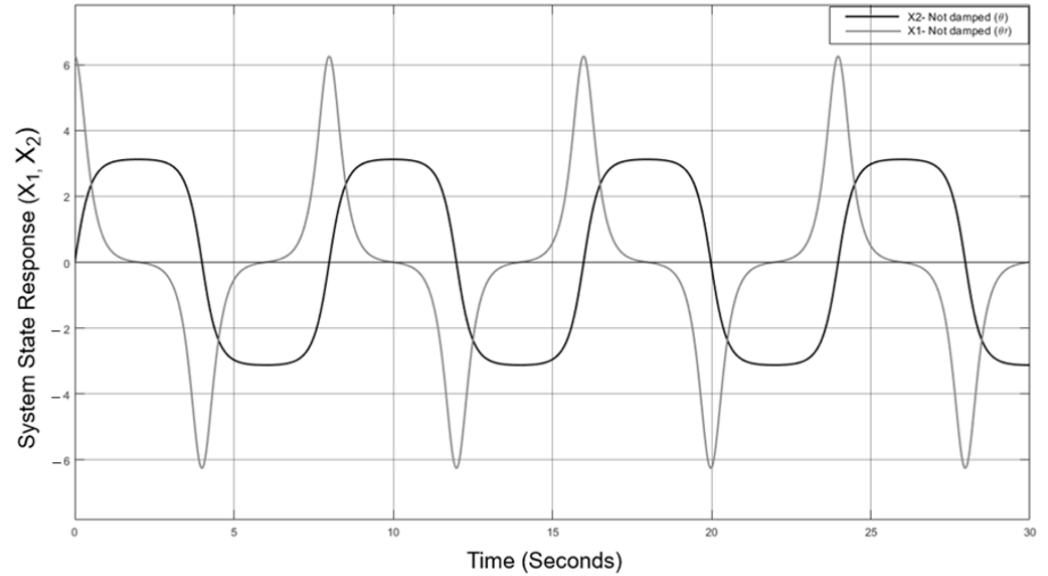
Figure 14. System state response indicative of the critical slowing down near an unstable equilibrium threshold (Case example 2 with [0, 6.264] initial conditions).